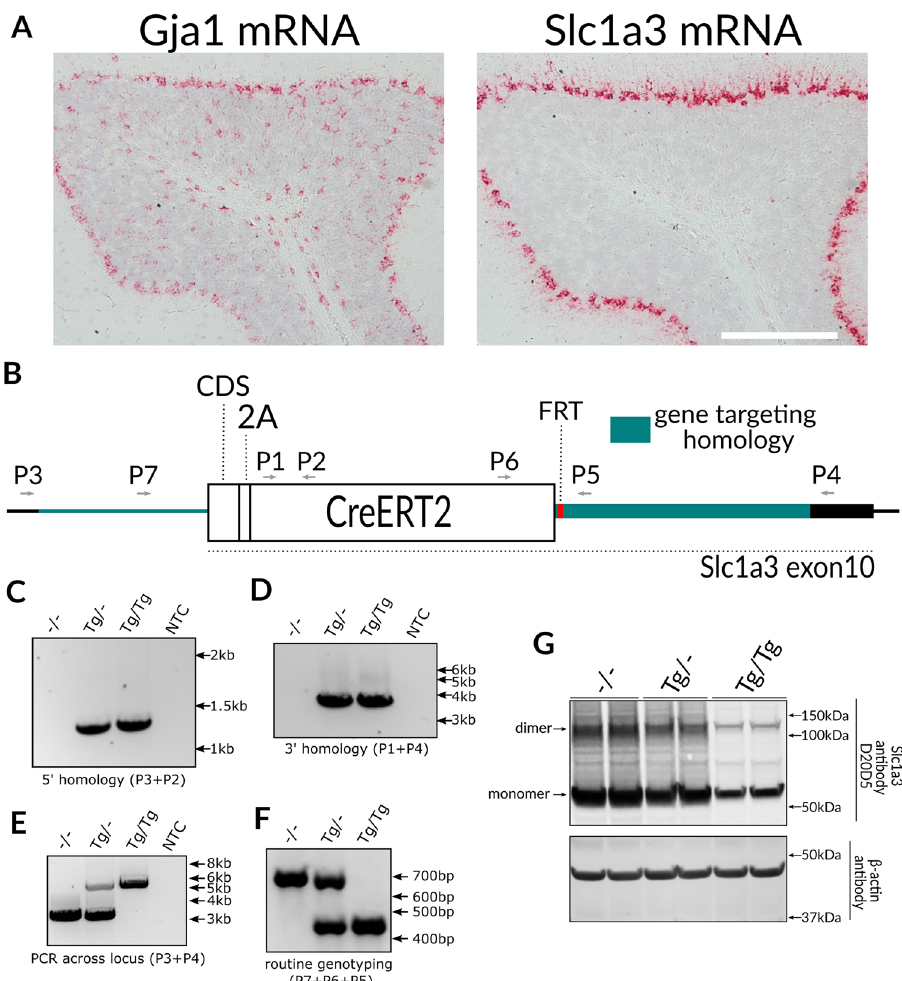
Figure 2. Generation of Slc1a3-2A-CreERT2 mice in 129S4 background. ( A ) In situ hybridization for Gja1 and Slc1a3 of a 10 months old mouse brain. Note disparate expression pattern in the cerebellum, where Slc1a3 is expressed almost exclusively in Bergman glia. (B) Schematic of Slc1a3-2A-CreERT2 targeted locus (elements are to scale). ( C – F ) Genotyping PCR. PCRs with primers flanking 5; homology region ( C ), 3 ′ homology region ( D ), flanking the whole targeted locus (we never managed to obtain the targeted band for heterozygote, probably due to WT target preference of the assay), ( E ), and routine genotyping assay ( F ) were shown. ( G ) Immunoblot using an anti-Slc1a3 antibody showing Slc1a3 protein levels in WT, heterozygous and homologous knock-in mice. PCR oligo sequences are in Supplementary Table S1 and uncropped images used to prepare panels C-G are shown in Supplementary Fig.